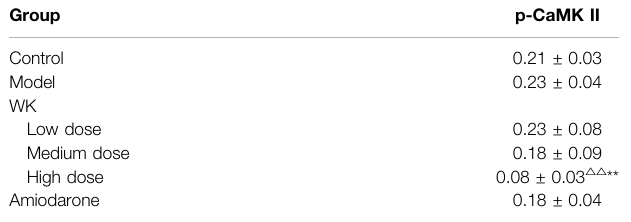
TABLE 6 | The level of P-CaMK II protein ( x ± s , n (cid:1) 8). Group